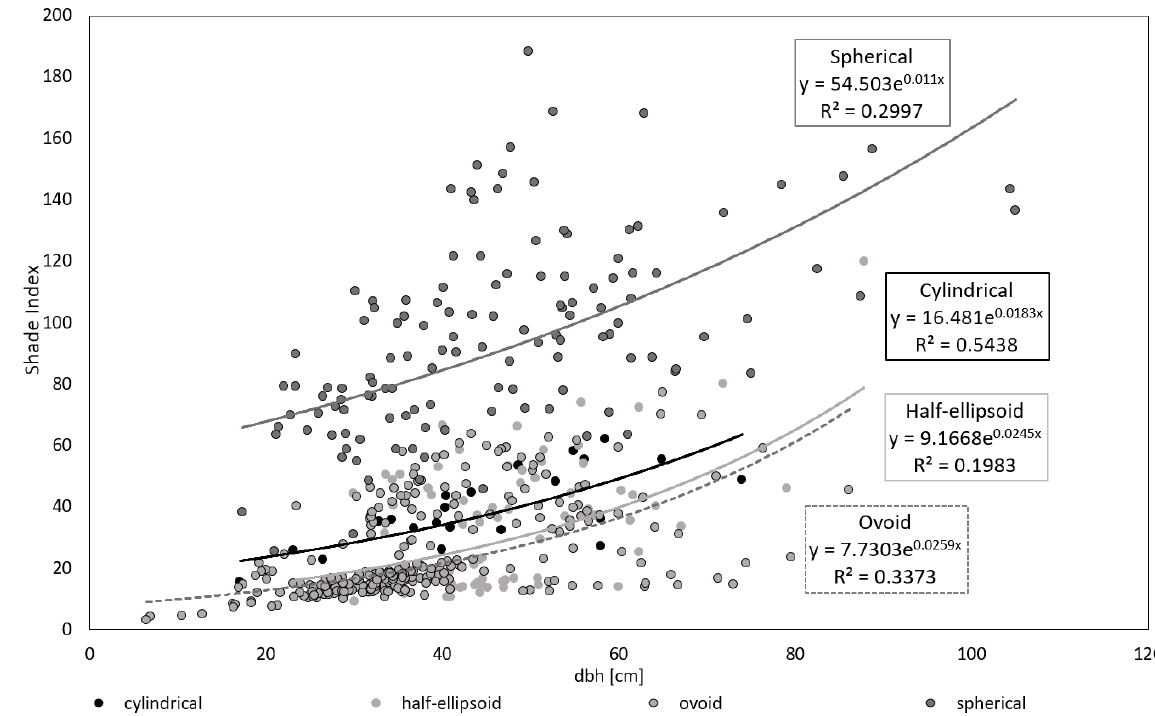
Figure 11. Dependency of shade index on tree dbh and crown shape. The mathematical constant e in the equations indicates the Euler’s number.